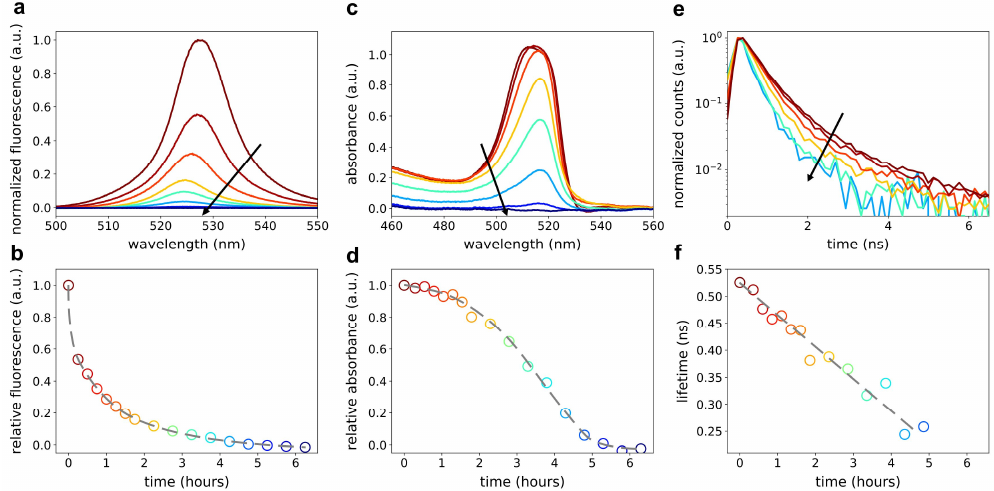
Figure 1. Complete degradation of an exfoliated phenethylammonium lead iodide (PEA 2 PbI 4 ) two-dimensional (2D) perovskite flake within 17 h of ambient conditions. First- and second-row show transmission and fluorescence micrographs of the flake, respectively.